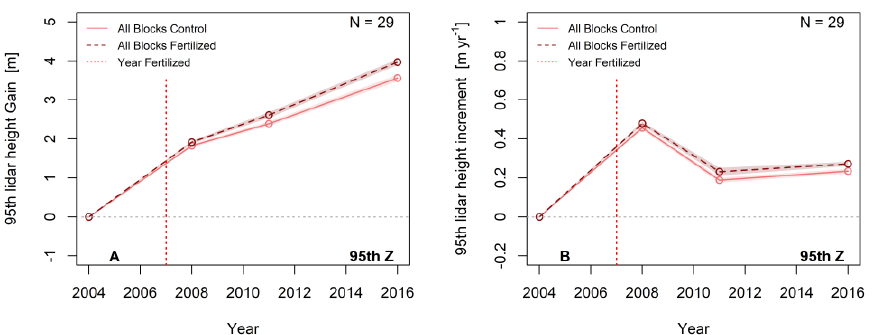
Figure 6. LiDAR block-level average (line) and standard error (shadow) of 95th percentile of LiDAR heights ( A ) and height periodic annual increments ( B ) for control blocks (solid) and fertilized blocks (dashed).